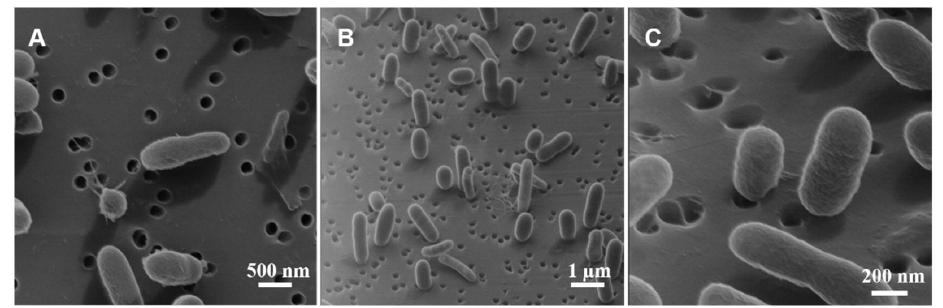
Figure 4. Helium ‐ ion microscopy (HIM) images of V. fischeri in the exponential phase (24 h timepoint). Ambiguity in interpreting the cell morphology based on the top ‐ down view ( A ) is re ‐ solved by tilting the stage 50° off ‐ normal ( B and C ).